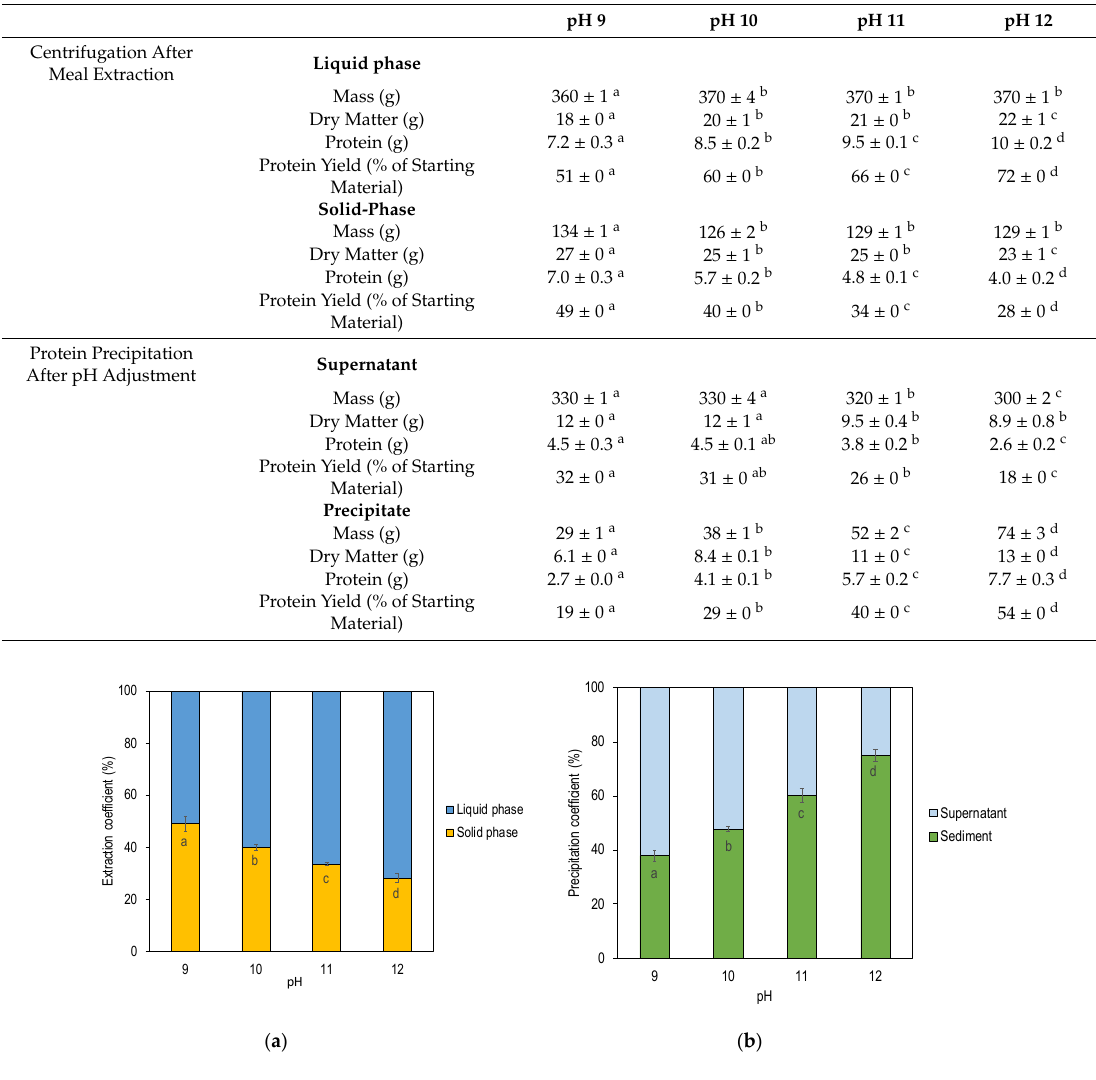
Figure 3. ( a ) Extraction coefficient displaying how rapeseed protein is distributed in the liquid phase and solid phase respectively after alkali extraction and separation. ( b ) Precipitation coefficient displaying how rapeseed protein is distributed after precipitation and separation. Data is an average of three extractions at each pH value. Different letters within each figure indicate significant difference p < 0.05.